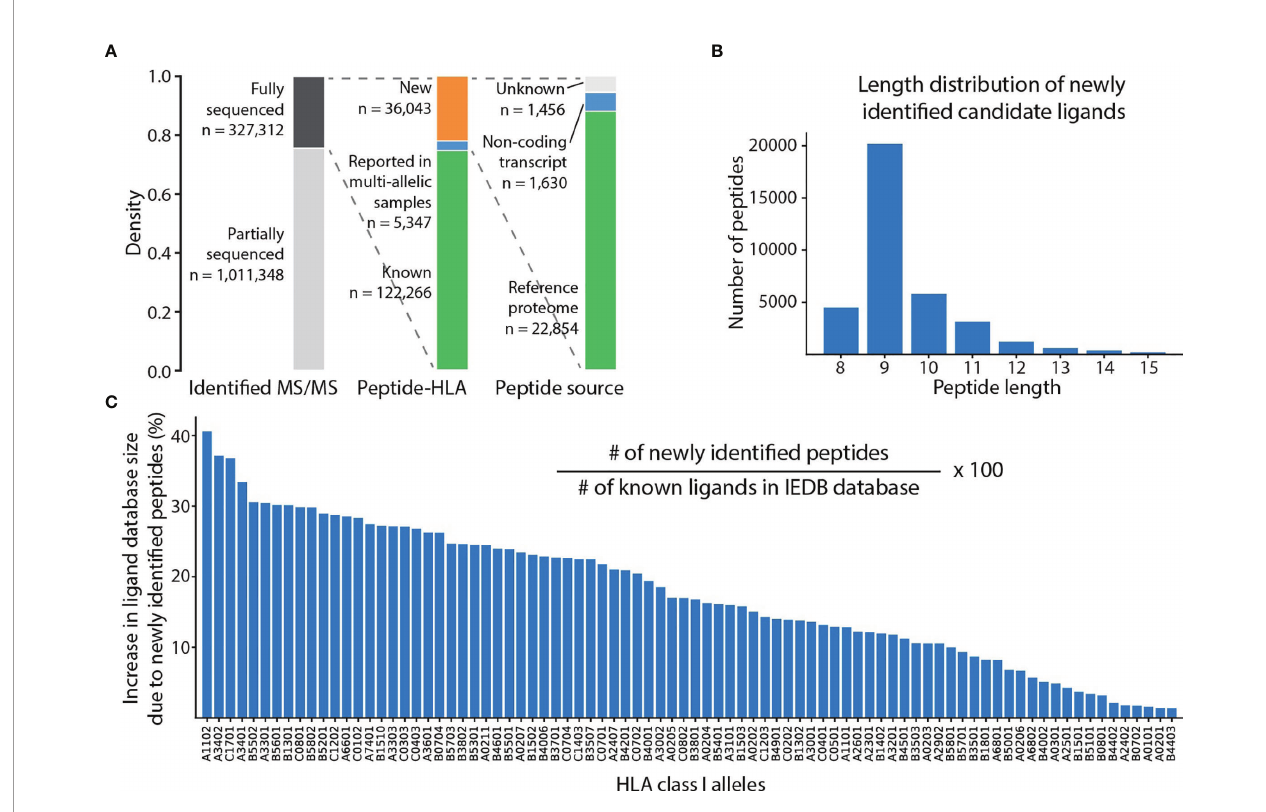
FIGURE 1 | SMSNet identi fi ed a large number of new ligands from public HLA peptidomics datasets. (A) Statistics of MS/MS spectra, peptide-HLA pairs, and the sources of peptides identi fi ed by SMSNet on mono-allelic HLA peptidomics datasets of 88 HLA class I alleles (see Methods). (B) Length distribution of all identi fi ed peptides. (C) Potential increase in the size of the database of known ligands from this study, assuming that all newly identi fi ed sequences are true ligands. The number of known ligands for each allele was extracted from the IEDB database by counting unmodi fi ed antigens and antigens with major modi fi cations, namely oxidized methionine and phosphorylated serine, threonine, and